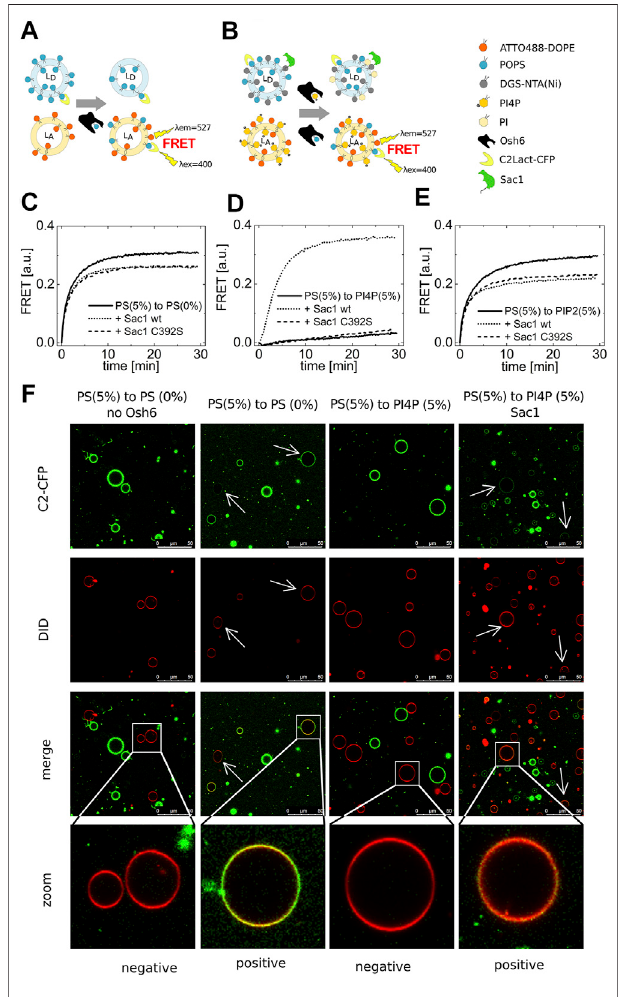
FIGURE1| PStransport. (A) and (B) SchematicsoftheFRETassaywith and without Sac1. Temporal evolution of the PS transport to LUVs composed of POPC solely (C) , to LUVs with 5 mol% of PI4P (D) , to LUVs with 5 mol% of PIP2 (E) . LUVs are either not decorated by Sac1 (solid curves), or are decorated by Sac1 wt (dotted curves), or by Sac1 C392S (dashed curves). (C – E) Representative curves out of at least three independent experiments. (F) Reconstitution of the PS transport to the membranes of GUVs. Red GUVs are PS-accepting GUVs, and presence of the green PS biosensor on the red GUVs refers to